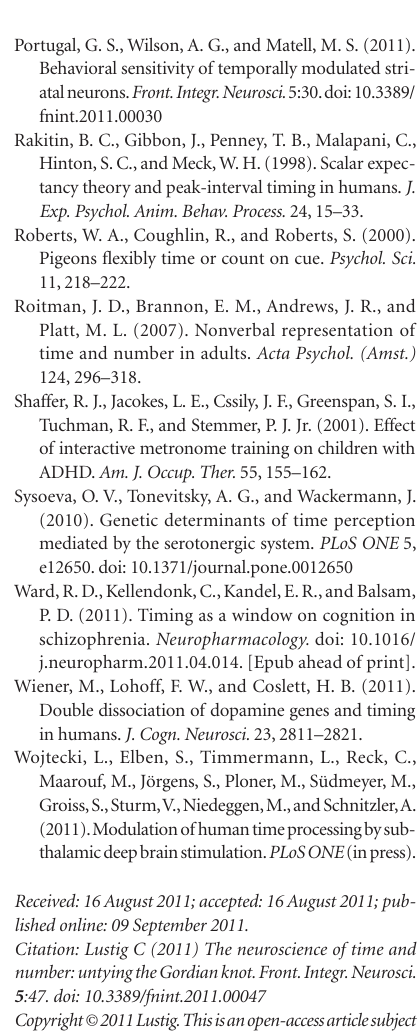
Citation: Lustig C (2011) The neuroscience of time and number: untying the Gordian knot. Front. Integr.